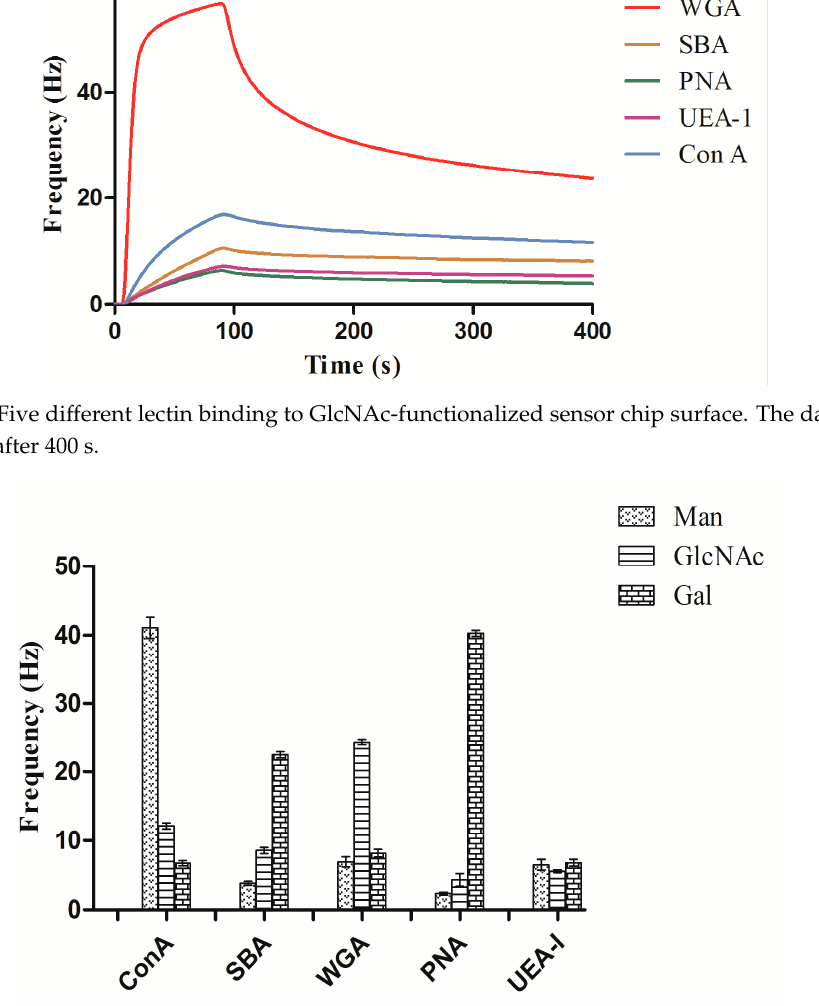
Figure 6. Binding between the five different lectins to the three carbohydrate sensor chip surfaces.